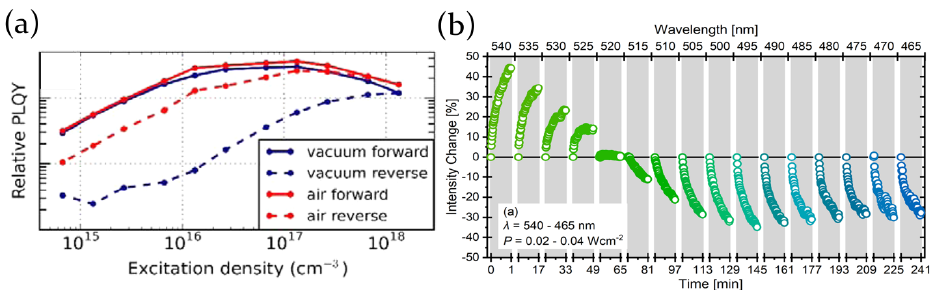
Figure 2. ( a ) Relative photoluminescence quantum yield (PLQY) curves of MAPbBr 3 polycrystalline thin films in air (red) and in a vacuum (blue). Adapted with permission from [59]. Copyright © 2016, American Chemical Society. ( b ) Percentage PL intensity change of a MAPbI 3 film for 60 s of illumination in air, for excitation wavelength between 540 and 465 nm (gray shades). Between each measurement the sample was kept for 15 min in the dark in order to reduce the overall stress (white columns); the emission was detected at the PL peak position (778 nm). Adapted with permission from [60]. Copyright © 2018, American Chemical